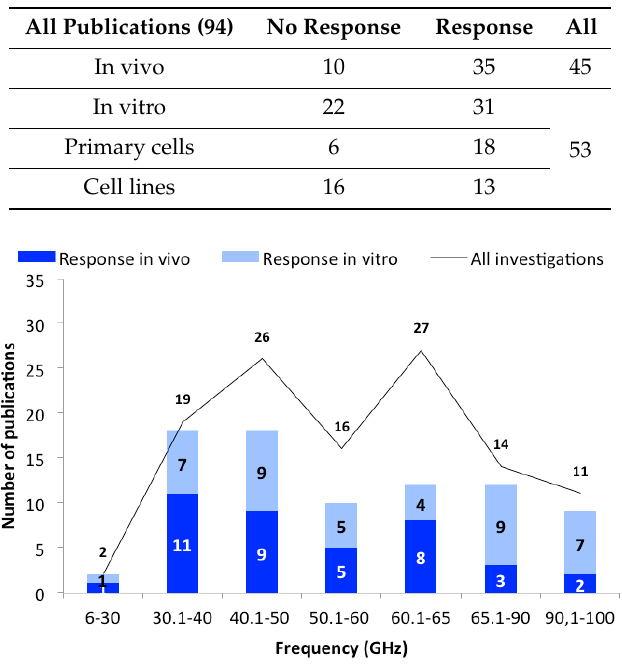
Table 2. Overview of the total number of publications examinations.